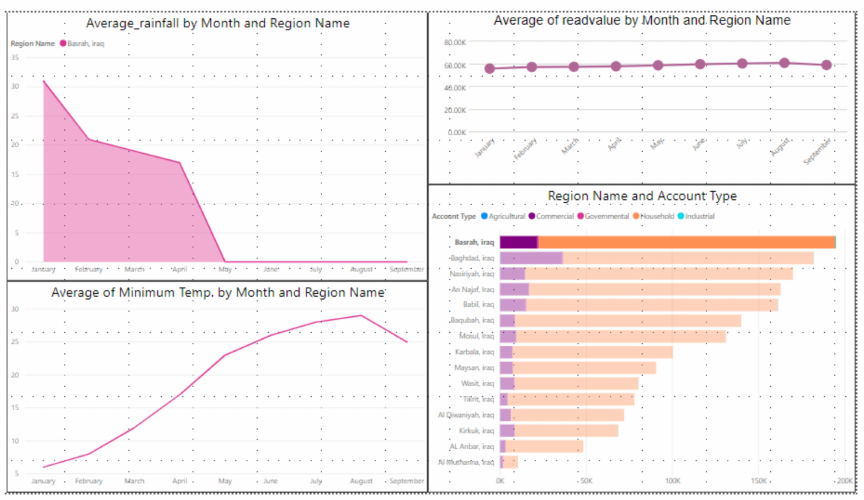
Figure 11. Dynamic Analysis of Basrah City.